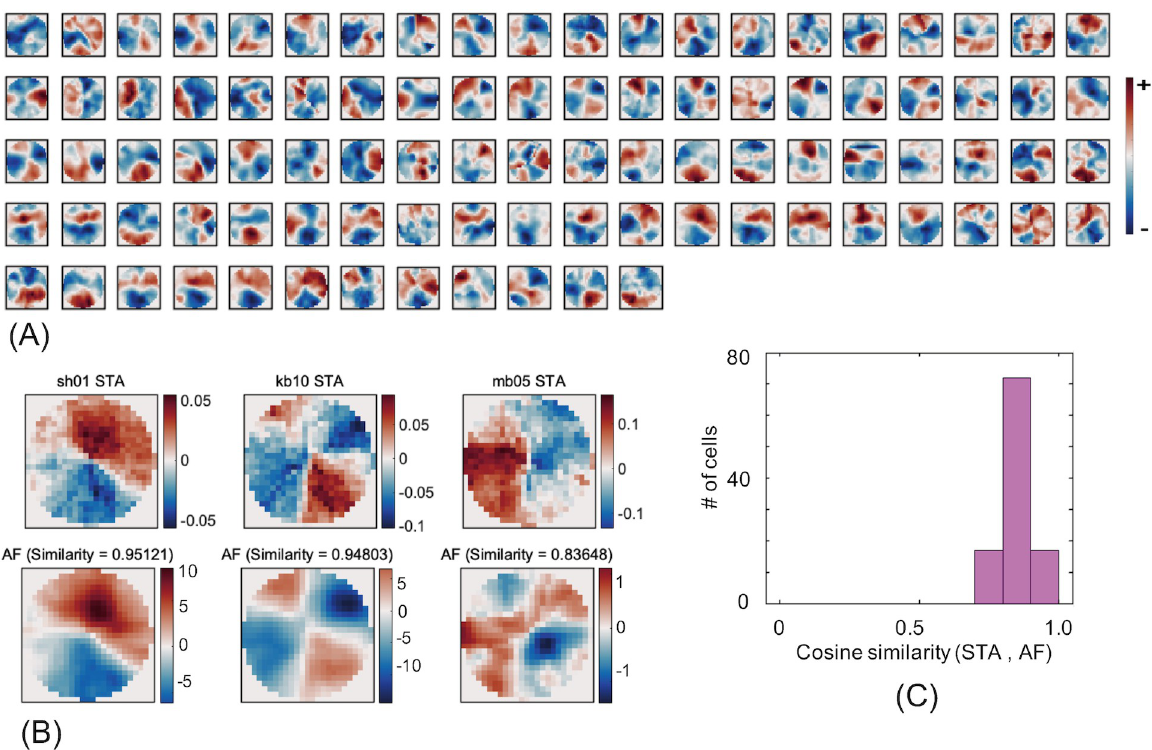
Fig 6. Estimated RF-FG AF s computed from the filled stimuli. (A) Estimated RF-FG AF s of the neurons that were shown in Fig 2. The same conventions were used as in Fig 2. (B) RF-FG STA s (top) and RF-FG AF s (bottom) of three example neurons with the cosine similarity between the two. Reddish and blueish colors indicate the regions that respond to figure and ground, respectively. Note that the magnitudes of RF-FG STA and RF-FG AF cannot be compared directly since RF-FG STA corresponds to the normalized bias towards figure and ground regions (positive and negative, respectively) while RF-FG AF corresponds to the spike rate (Hz) when multiplied with a stimulus and rectified. (C) Distribution of the cosine similarity between the normalized RF-FG STA and RF-FG AF . The RF-FG STA and RF-FG AF show characteristics similar to each